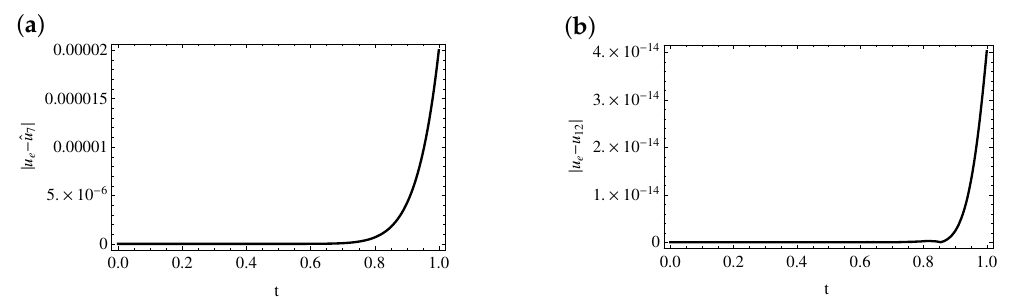
Figure 7. Distribution of error of the exact solution approximation for n = 7 ( a ) and n = 12 ( b